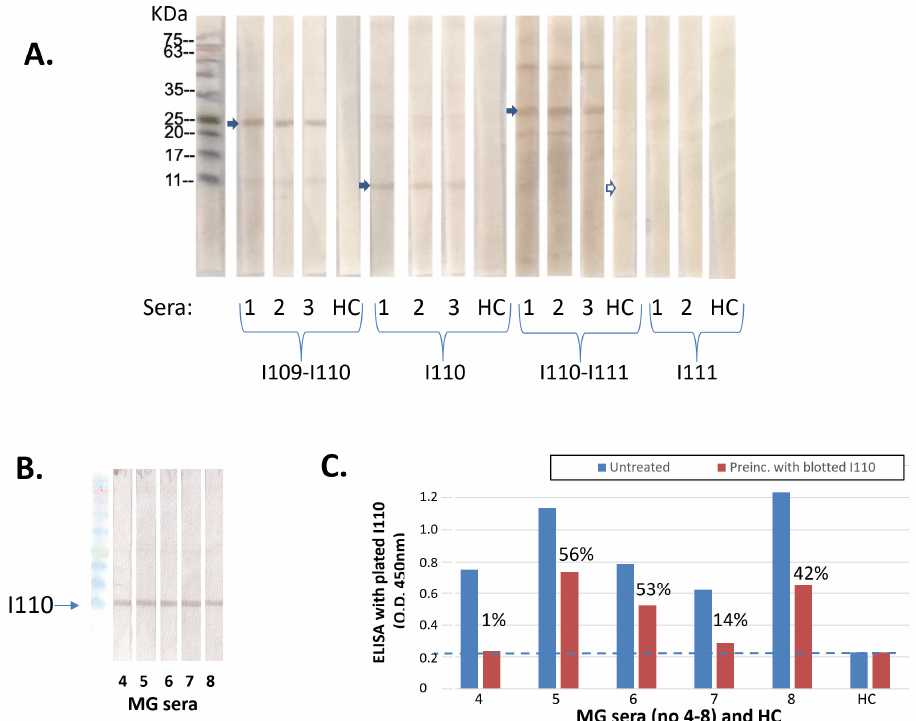
Figure 6. Binding of anti-titin antibodies to denatured I110 domain by Western blotting. ( A ) Titin MIR samples were SDS-electrophoresed and transferred onto polyvinylidene difluoride (PVDF) membranes, which were then incubated with 1/100 dilutions of 3 test MG sera, and a HC serum. It is shown that all MG sera recognized the I110 and the two I110-containing fragments but not the I111 fragment, whereas the HC serum showed no binding to any fragment. ( B ) Five more MG anti-MIR/I110 sera were incubated with blotted I110. ( C ) The incubated “depleted” sera of 6B were then used in ELISA with immobilized I110 fragment and compared with the binding of the corresponding untreated sera. Blue columns: untreated sera; red columns: treated “depleted” sera. Percentages above red columns denote the % of unbound I110 antibodies (after deduction of the background values marked with the dotted line). The average % of unbound antibodies was 33%.